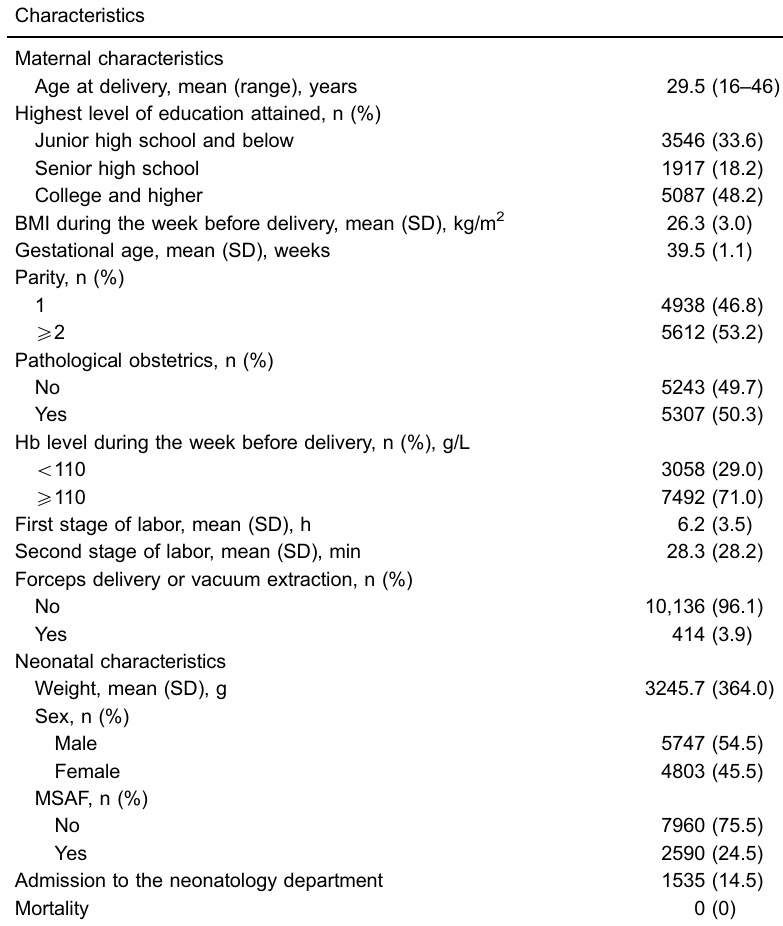
Table 1. Maternal and neonatal clinical characteristics of single-gestation infants born through vaginal delivery from 37 weeks 0 days to 41 weeks 6 days.